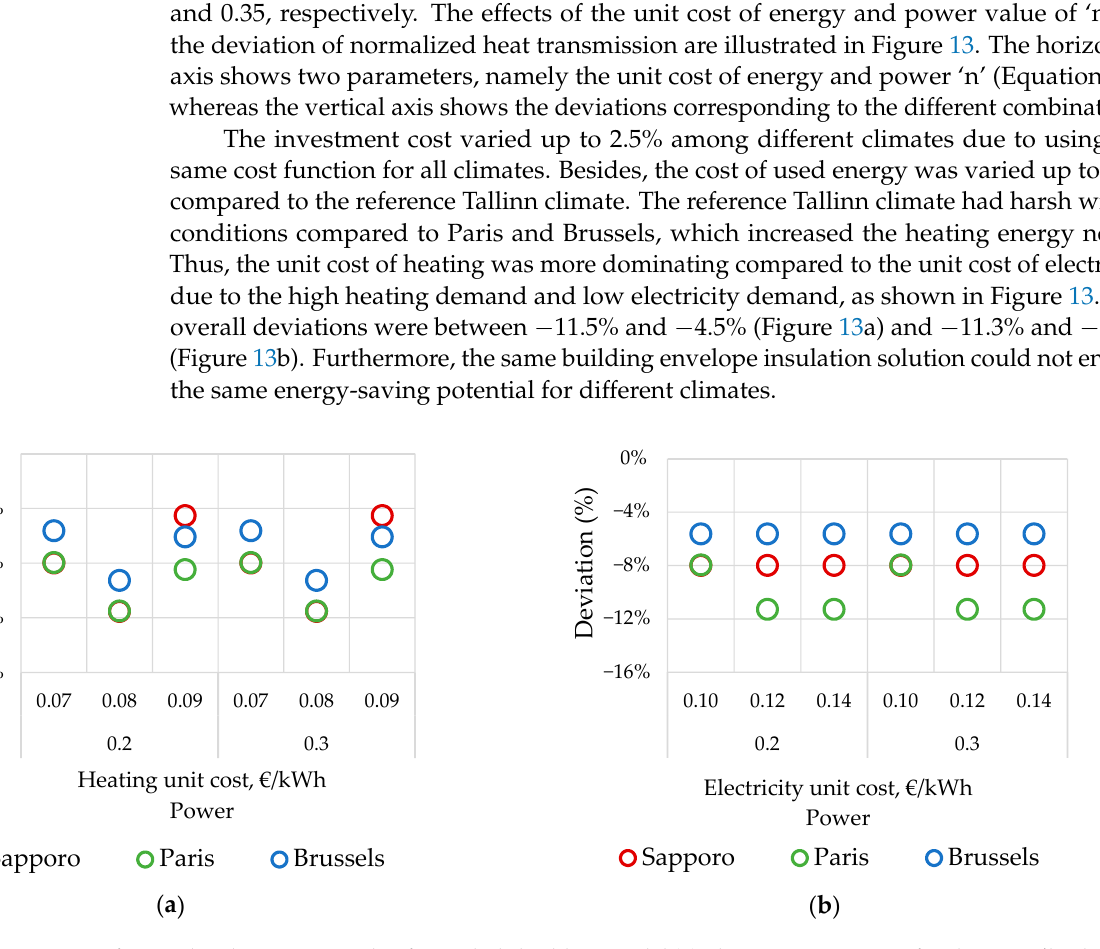
Figure 13. Deviation of normalized average U-value for a whole building model ( a ) Electricity unit cost is fixed to 0.1 €/kWh, ( b ) Heating unit cost is fixed to 0.07 €/kWh (lowest cost-optimal solution based on investment and operational heating and cooling cost).